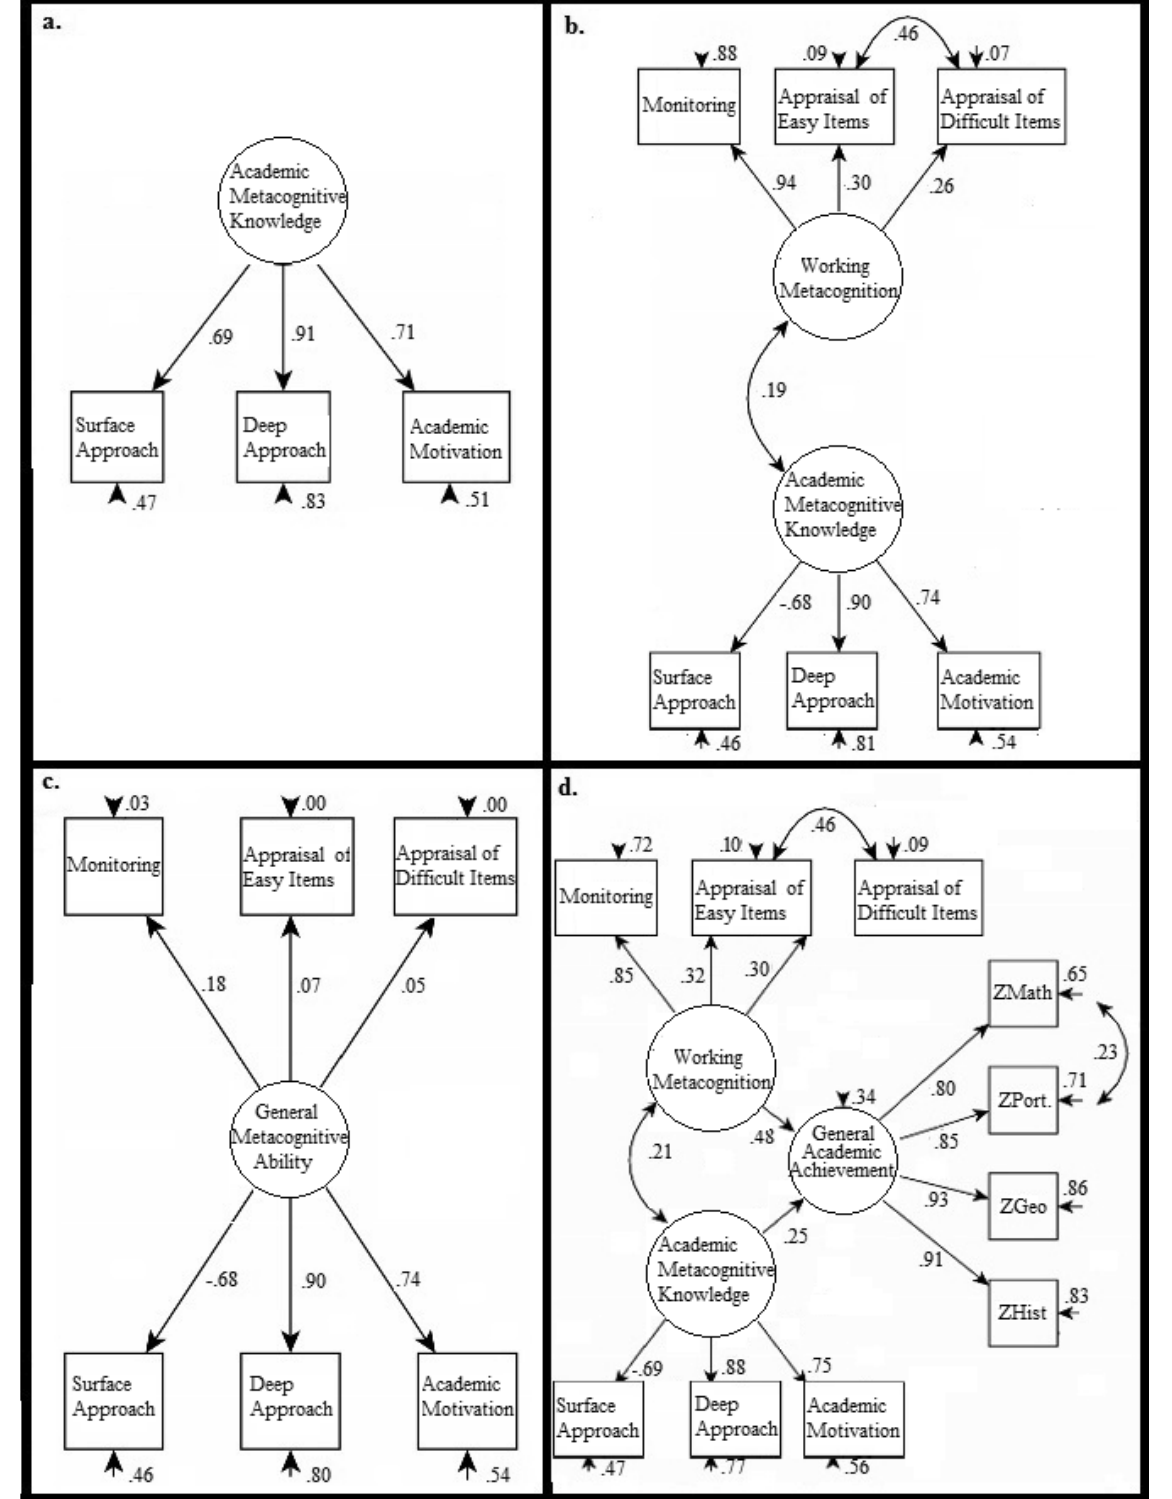
Figure 2 . Tested